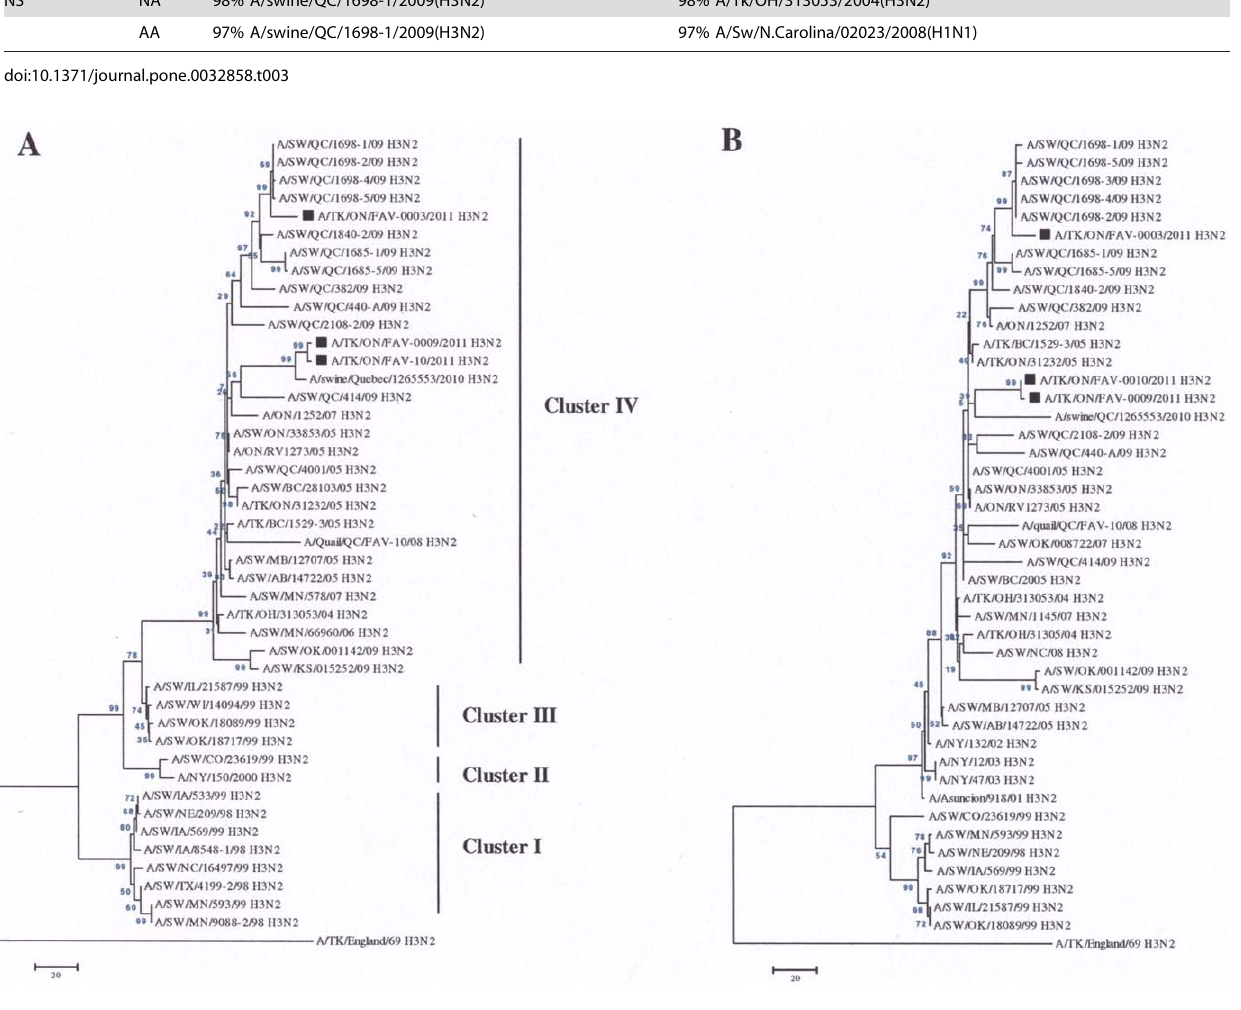
Figure 1. Phylogenetic analysis of the HA and NA genes. The HA (a) and NA (b) gene segments of the unique TR H3N2 viruses isolated from turkeys were compared with other TR H3N2 viruses from turkey (open circle), quail (open diamond) and pig (open triangles) that were previously sequenced by our laboratory [24]. doi:10.1371/journal.pone.0032858.g001 PLoS ONE |